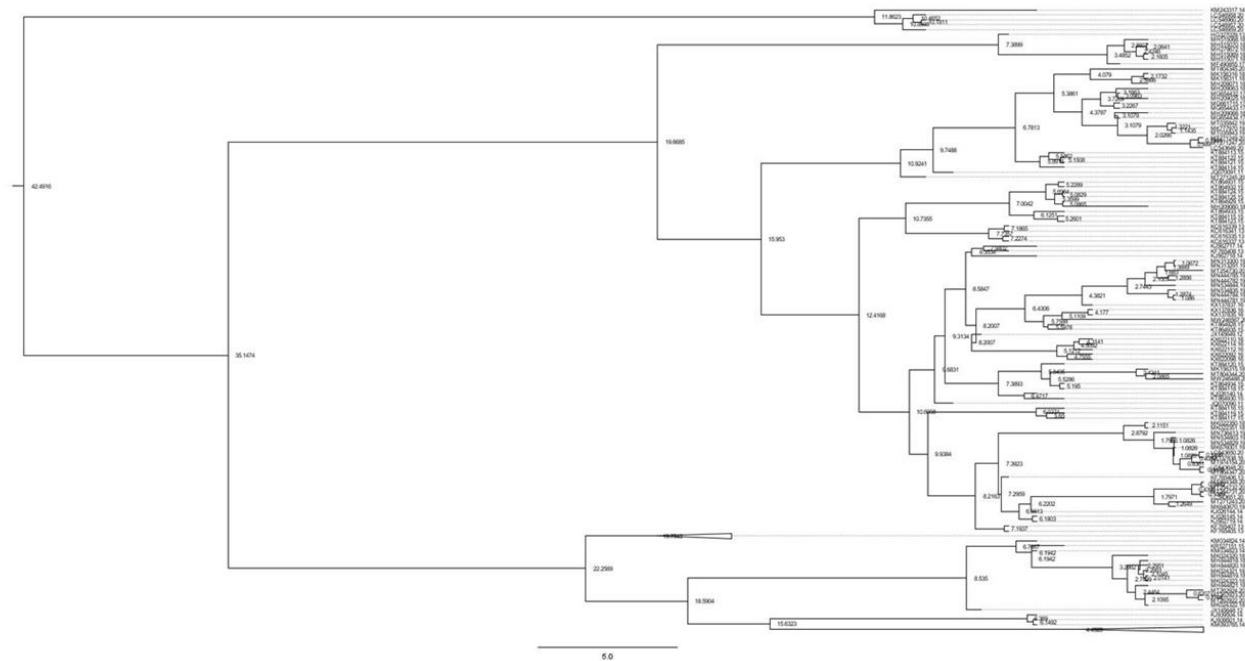
Figure 4. Chronogram with divergence times. Numbers annotated on each node represent the divergence times between clades and the standard deviations (95% of high posterior density) are represented by the blue bars.